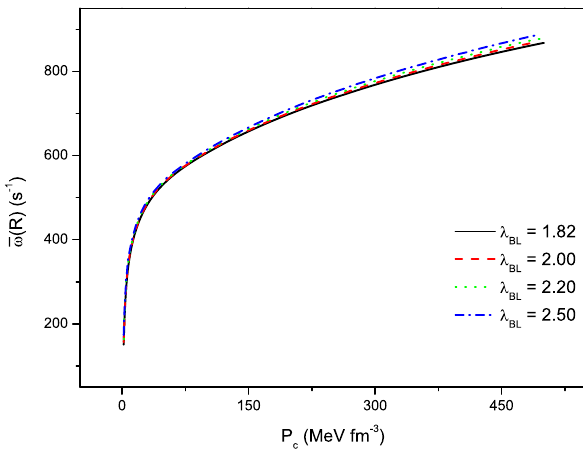
Fig. 1 The center pressure and angular velocity of NS relation. The angular velocity is evaluated at the star’s surface, i.e., ¯ ω( R ) . We used four values of λ BL , which represent the strength of anisotropic terms. The influence of the star’s anisotropic pressure can be seen obviously after P c has already exceeded 150 MeV fm − 3